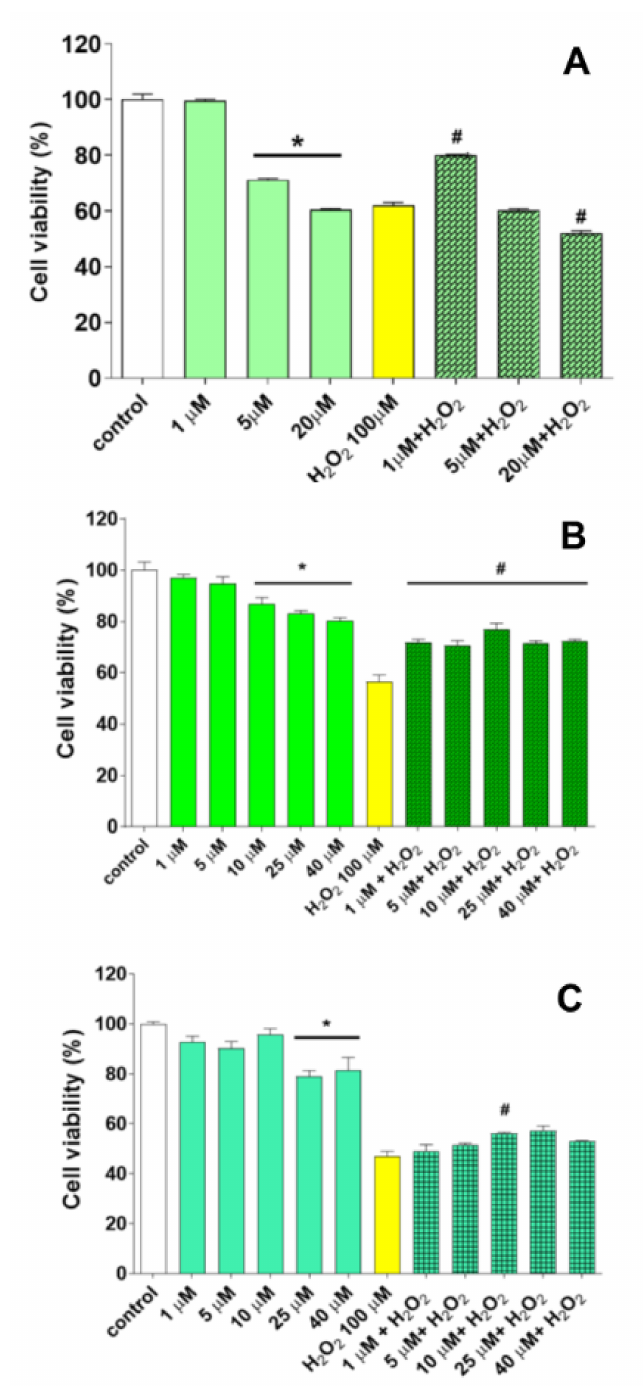
Figure 8. Effects of compounds 1 ( A ), 6 ( B ) and 7 ( C ) on damage induced by H 2 O 2 (100 µ M). Experiments were made on PC12 cells. MTT assay, to assess cell viability, was performed 24 h after each treatment. * p < 0.05 vs. control; # p < 0.05 vs. H 2 O 2 . In each panel: white column: control viability; no-texture columns: viability associated with increasing concentrations of the compound; yellow column: 100 µ M H 2 O 2 associated viability; textured columns: viability associated with increasing concentrations of the compound in the presence of 100 µ M H 2 O 2